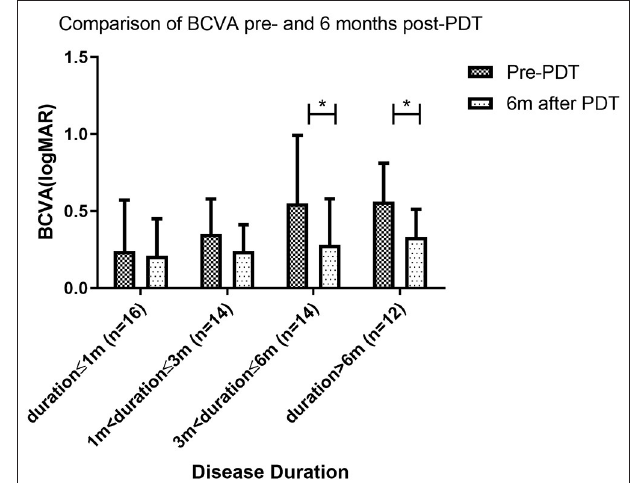
FIGURE 6 | Comparison of BCVA pre- and 6 months post-PDT. At 6 months follow up after photodynamic therapy (PDT), the best corrected visual acuity (BCVA) of patients with disease duration longer than 3 months was significantly better than BCVA pre-PDT. However, BCVA was similar pre- and post-PDT for patients with disease duration of 3 months or less (* indicates statistical